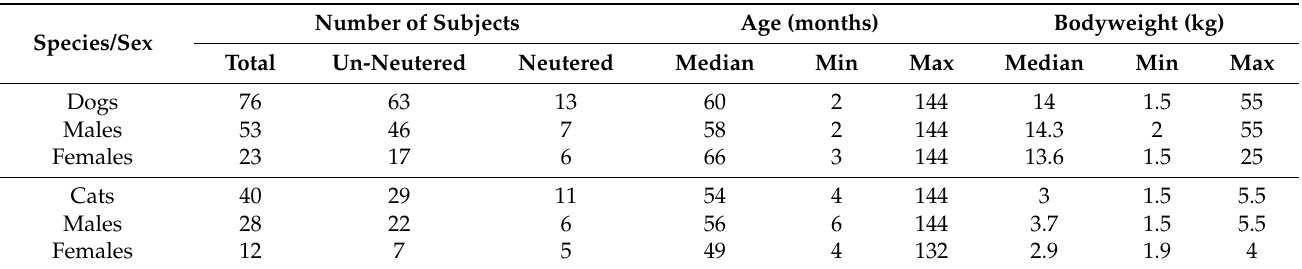
Table 1. Characteristics of sample